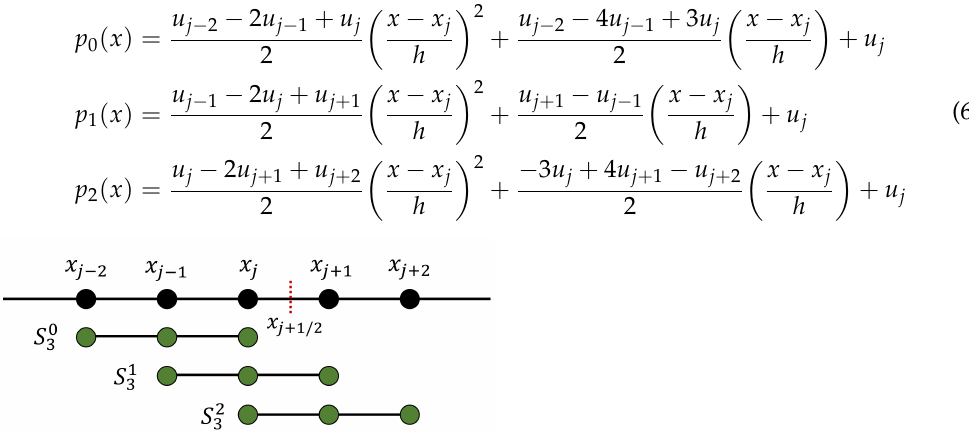
Figure 1. Interpolation stencils for the fifth-order WCNS